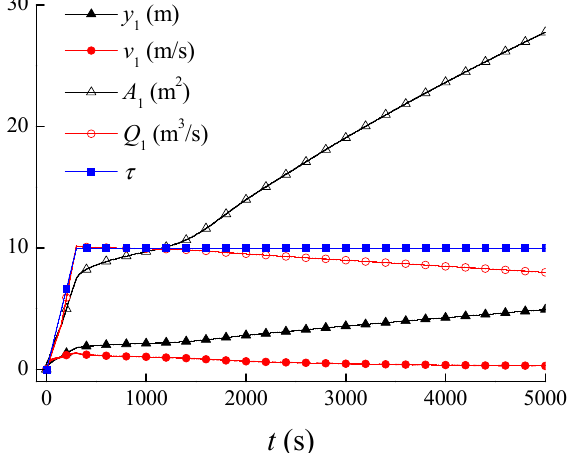
Figure 13. Parameters of the first profile in a water filling process (Stage 1).